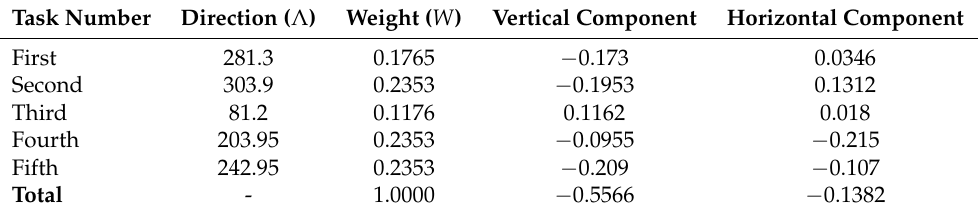
Table 4. The vertical and horizontal components of each session’s edge, calculated using the classical vectors analysis. Task Number Direction ( Λ ) Weight ( W ) Vertical Component Horizontal Component First 281.3 0.1765 − 0.173 0.0346